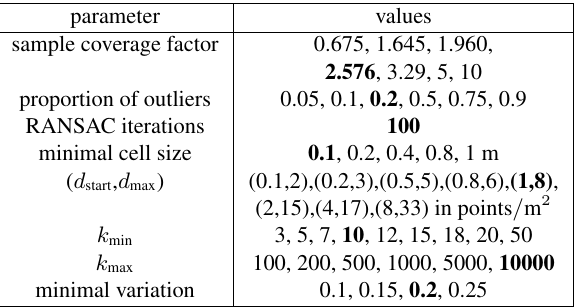
Table 2. Evaluated parameter values and their default values